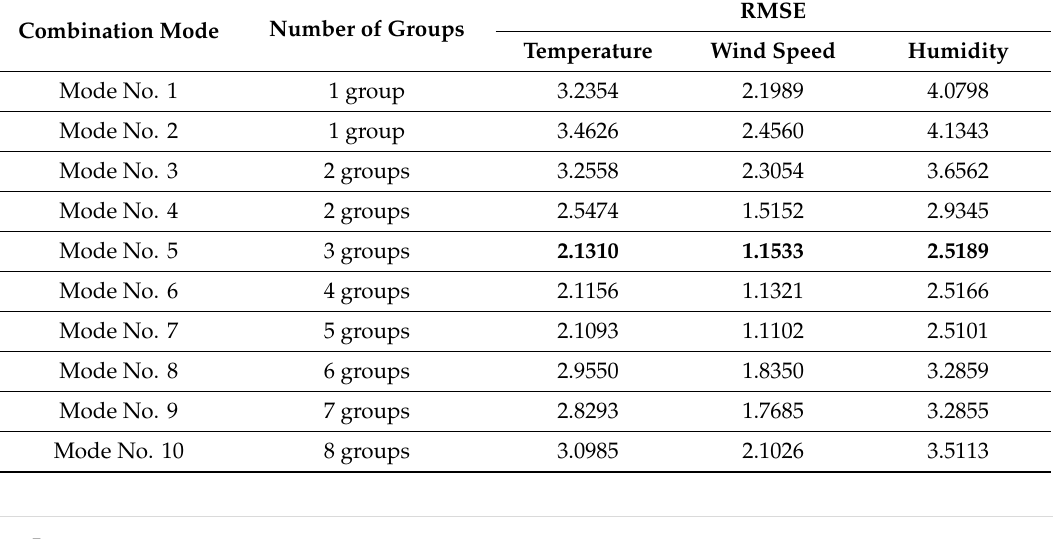
Table 3. Comparison of RMSEs of prediction results with di ff erent groupings.